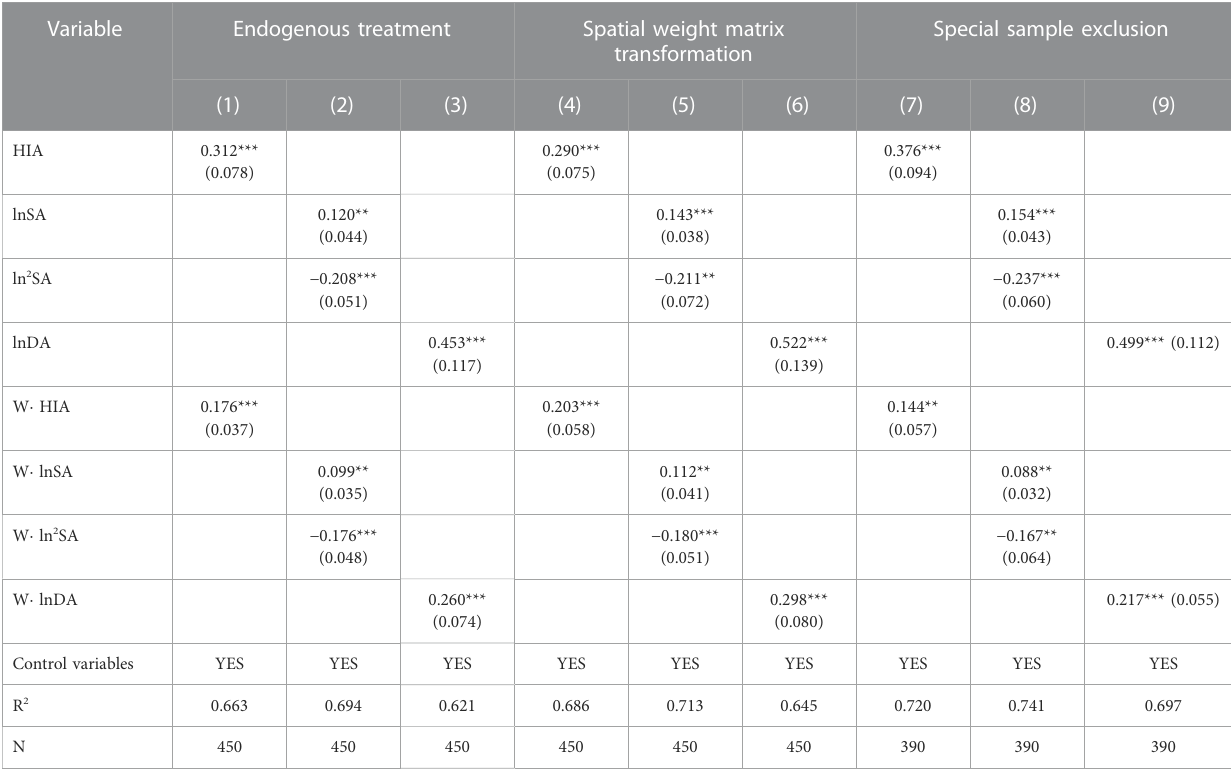
TABLE 6 Results of endogeneity and robustness